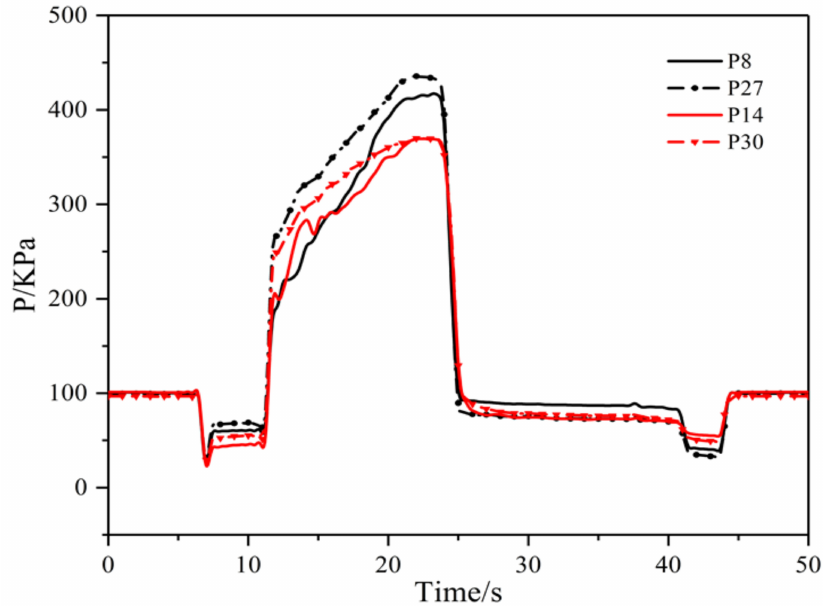
Figure 14. Internal pressure of the cavity and pressure of the mainstream at the same flow direction vs. time.